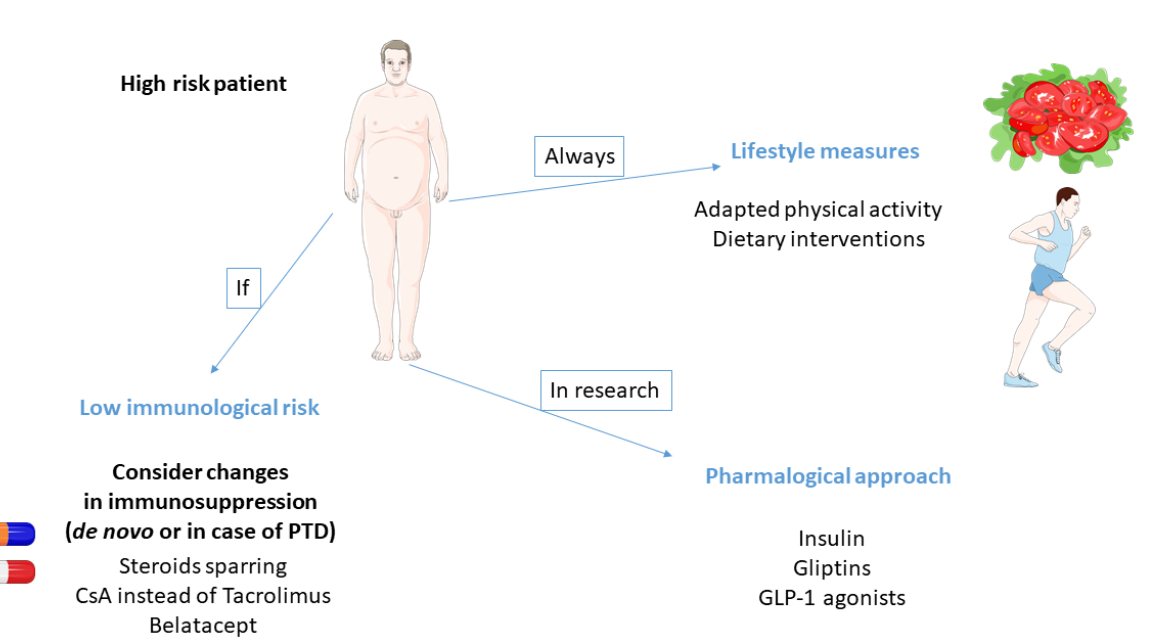
Figure 2. Summarized prevention strategies in post-transplant diabetes.